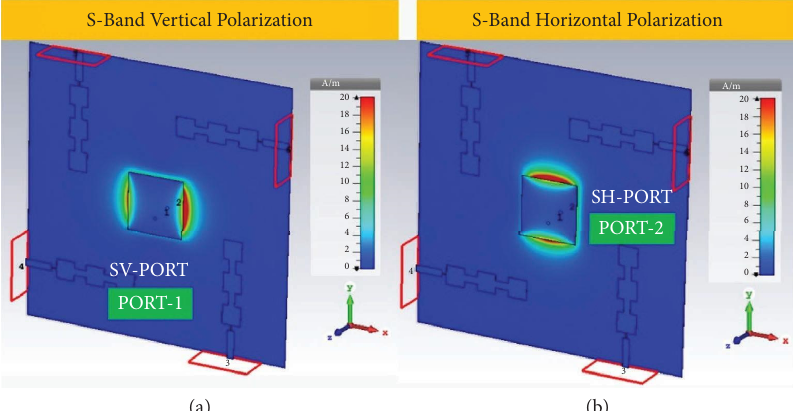
Figure 8: (a) Surface current distribution of S-band port 1 (SV-PORT). (b) Surface current distribution of S-band port 2